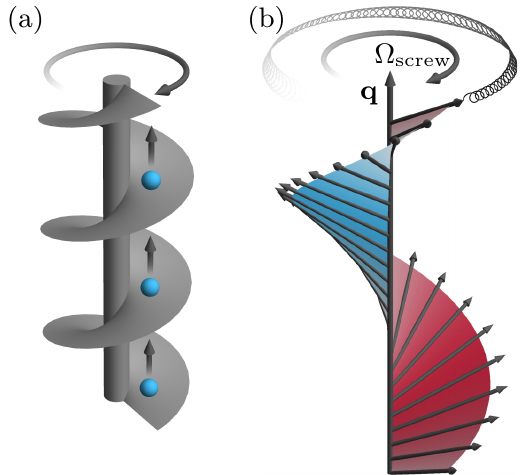
Figure 1: Panel (a) Simplified illustration of an Archimedean screw. A rotation of the screw induces an upwards motion of the material inside (blue spheres). Panel (b) Dynamics of a conical state driven by an oscillating magnetic field perpen- dicular to q . In fading black the oscillations of a selected spin is shown at the top of the figure. The oscillating field induces a fast precession which triggers a slow screw motion of the magnetic texture. An animated version of this figure is shown as a supplementary